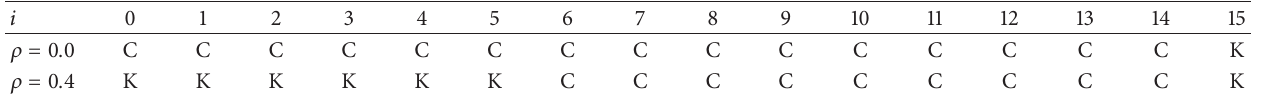
Figure 1: Graphs of 𝐽(𝑥) and ℎ 𝑖 . If 𝐽(ℎ 𝑖 ) > 0 , adopting the admission control policy is optimal; otherwise, the pricing control policy is optimal. Table 1: Optimal search